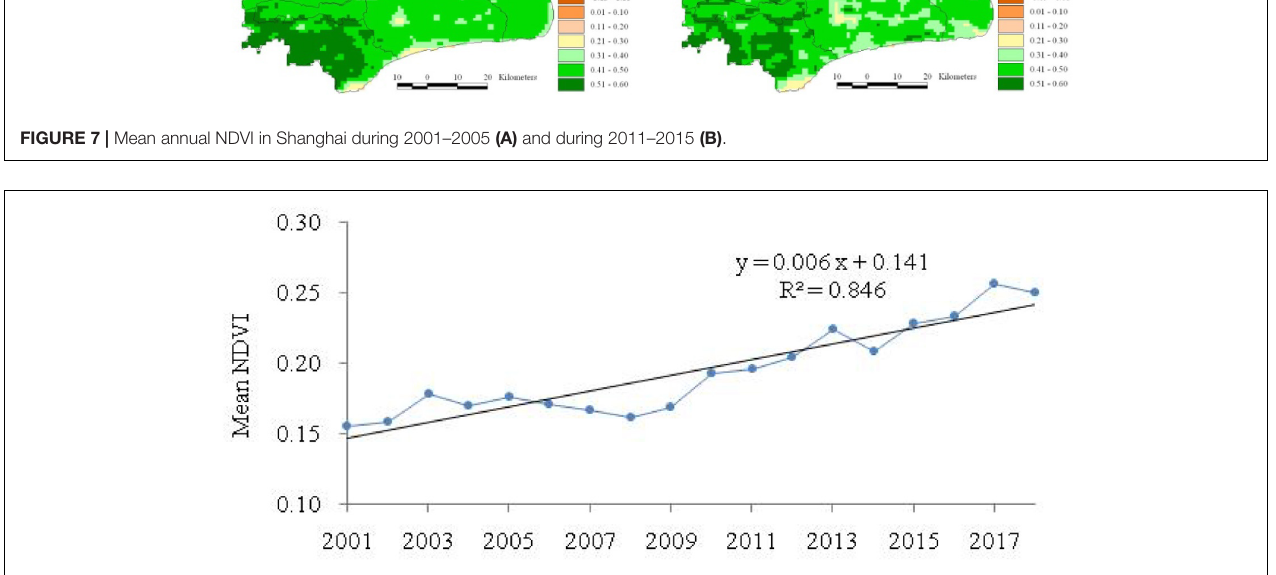
FIGURE 8 | The annual change of NDVI in the urban areas of